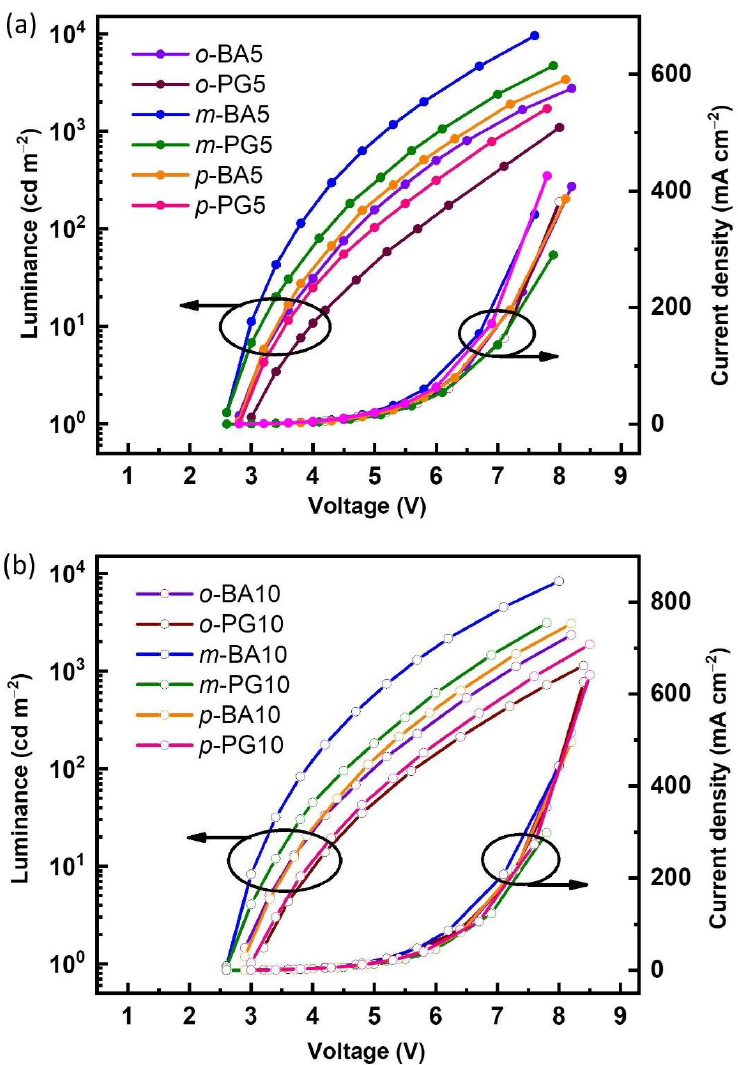
Figure 5. Current density – voltage – luminance ( J – V – L ) curves of series of devices with doping concentrations of 5 wt% ( a ) and 10 wt% ( b ).